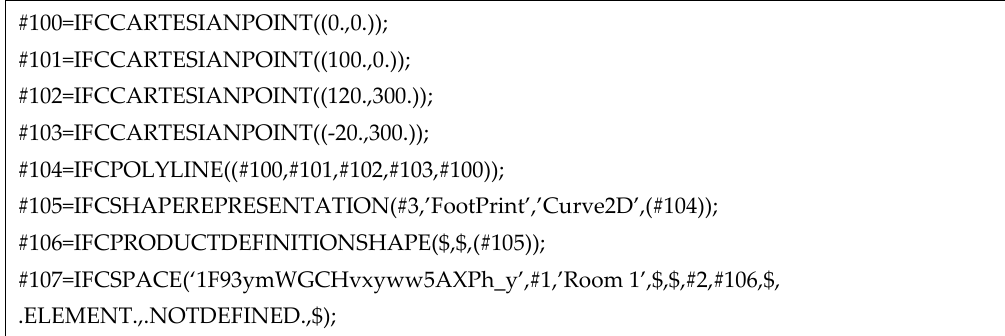
Figure 8. Snippet of IFC illustrating a section of a 2D footprint. ISPRS Int. J. Geo-Inf. 2017 , 6 , x FOR PEER REVIEW